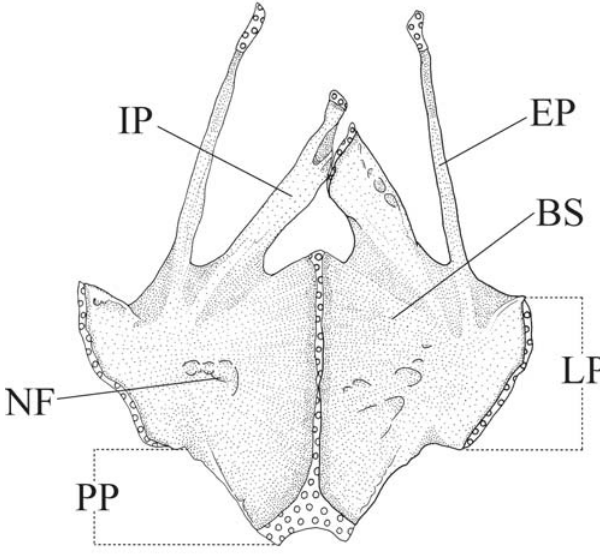
Fig. 10. Pelvic girdle of Rhamdiopsis krugi , LIRP 5928, 33.9 mm SL, paratype. Dorsal view. BS ) basipterygium; EP ) external anterior process (or anterolateral arm); IP )